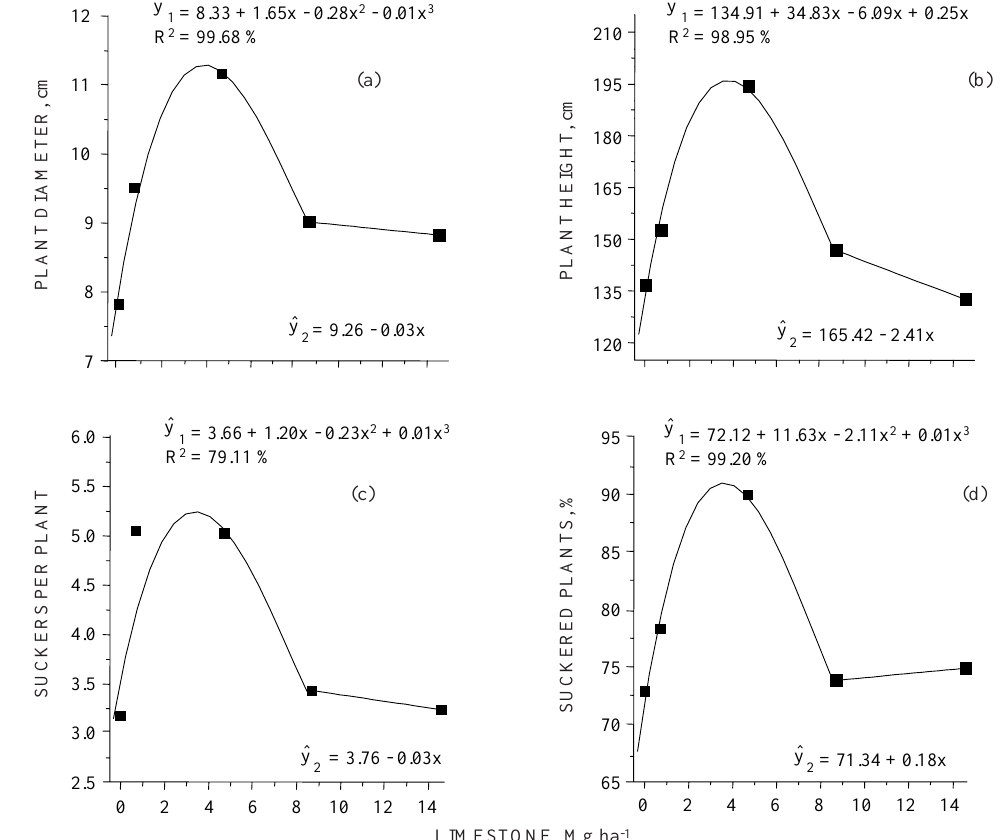
Figure 1. Mean growth of peach palm plants submitted to five liming rates, evaluated for plant diameter (a), plant height (b), number of suckers (c), and percentage of plants with suckers (d). Bars represent the standard deviation. Pariquera-Açu, São Paulo,